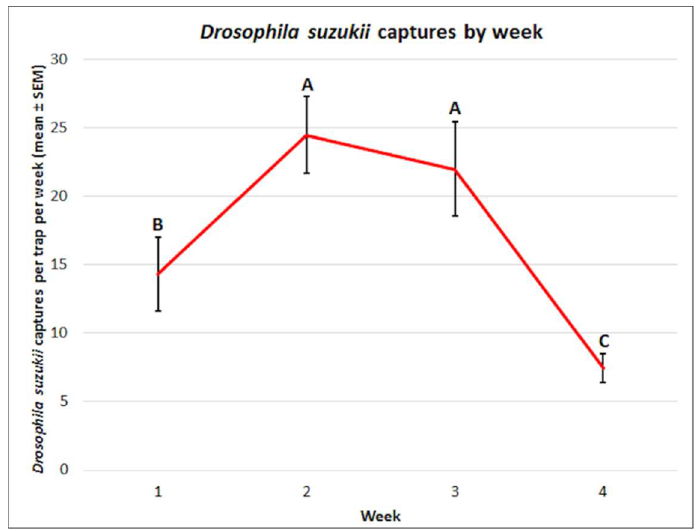
Figure 4. Mean (± SEM) Drosophila suzukii captures by week. Different letters represent statistically significant differences ( p < 0.05, Tukey’s HSD test) between attractant solutions.